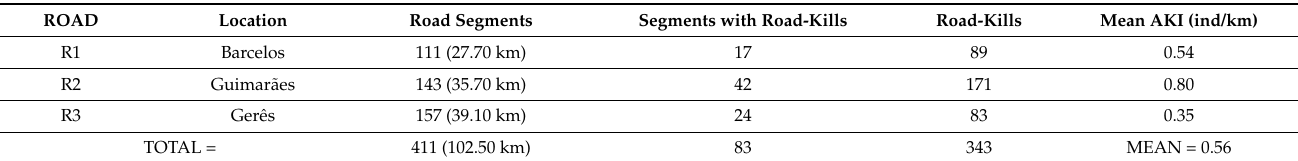
Table 2. Selected road locations, number of road segments (and total segments length), number of road segments with road-kills, number of road-killed amphibians, and mean computed abundance kilometer index (AKI; number of road-killed amphibians per kilometer).